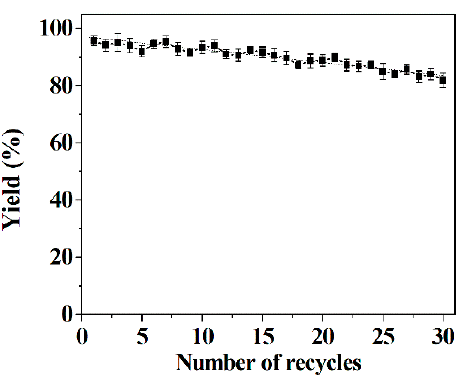
Figure 7. Reusability of co-immobilized tri-enzymes. Reaction conditions of each run: 35 mg of co-immobilized tri-enzymes; 200 mM of HMF; 37 °C; Tris-HCl buffer (50 mM, pH 6.6).